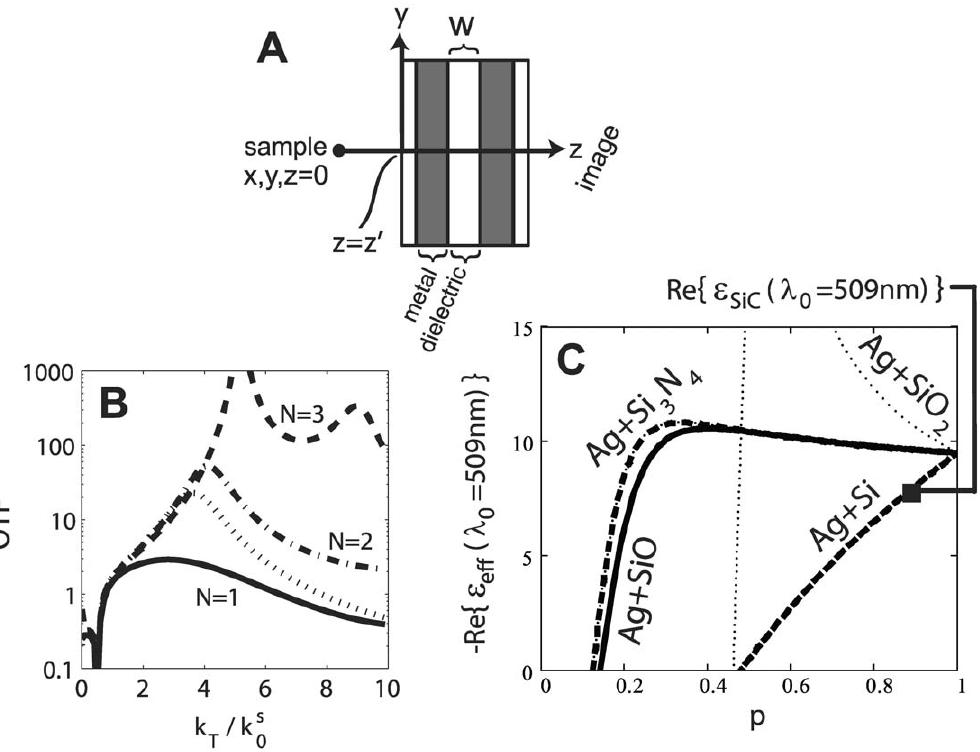
Figure 1. Superlens design and properties. (a) Sketch of the considered superlens with N ~ 2 . (b) The Optical Transfer Function (OTF) of the ( k T is the transverse wavevector and k s is the total wavevector in the source medium), for N ~ 1,2 & 3 . The total superlens as a function of k T (cid:1) k s 0 0 thickness and metallic-layer fraction is kept constant. The dotted line represents N ~ 10 . ( c ) Effective medium theory calculation of the real part of the dielectric function of the metal layers for various dielectric inclusions as a function of metal filling factor ( p ). Values are evaluated at the effective emission frequency of a dipole (with l 0 ~ 509 nm) a distance z ’ ~ 15 nm infront of the superlens (see text).